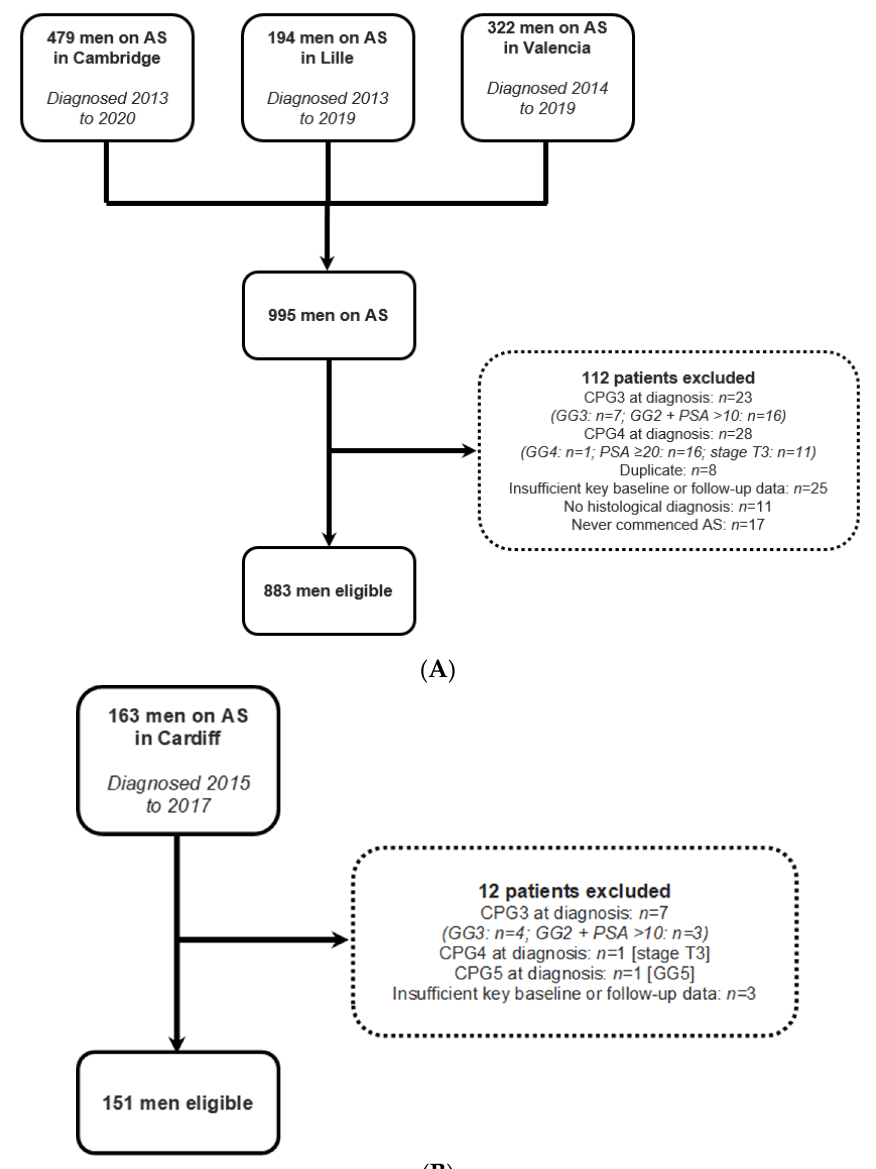
Figure 1. Data assembly process for the ( A ) development cohorts, and ( B ) external validation cohort. AS, active surveillance; CPG, Cambridge Prognostic Group; GG, grade